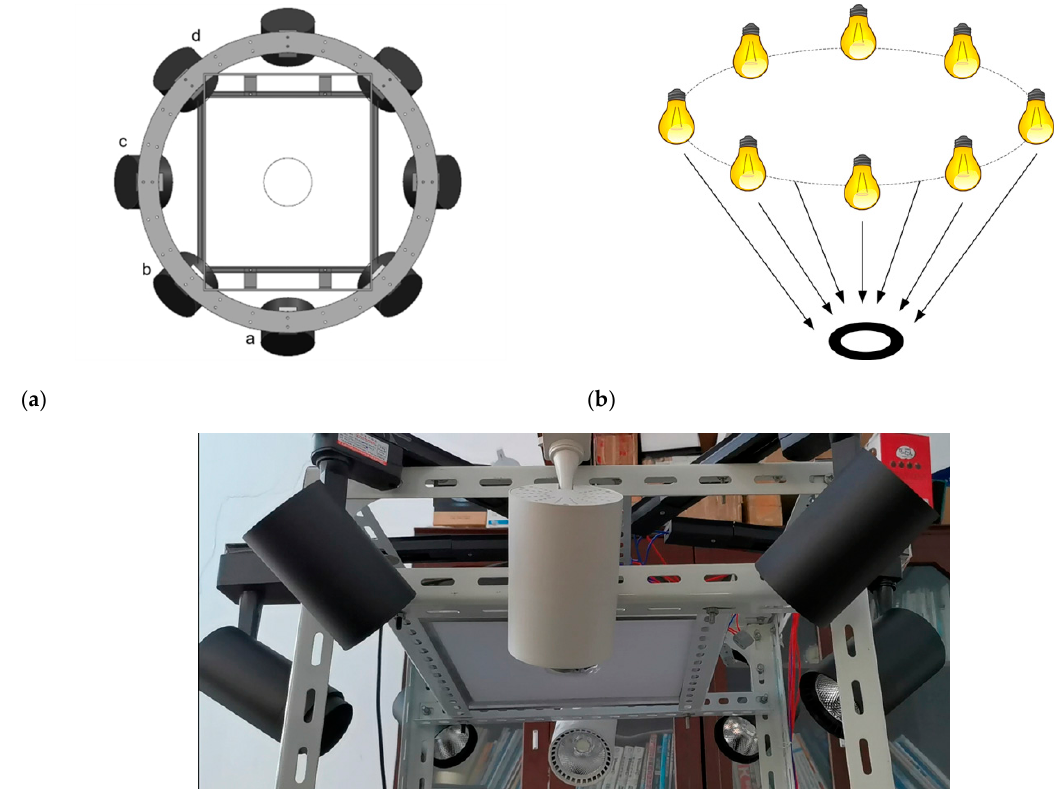
Figure 2. Imaging system. ( a ) The model of light source; ( b ) illumination schematic diagram; ( c ) light source